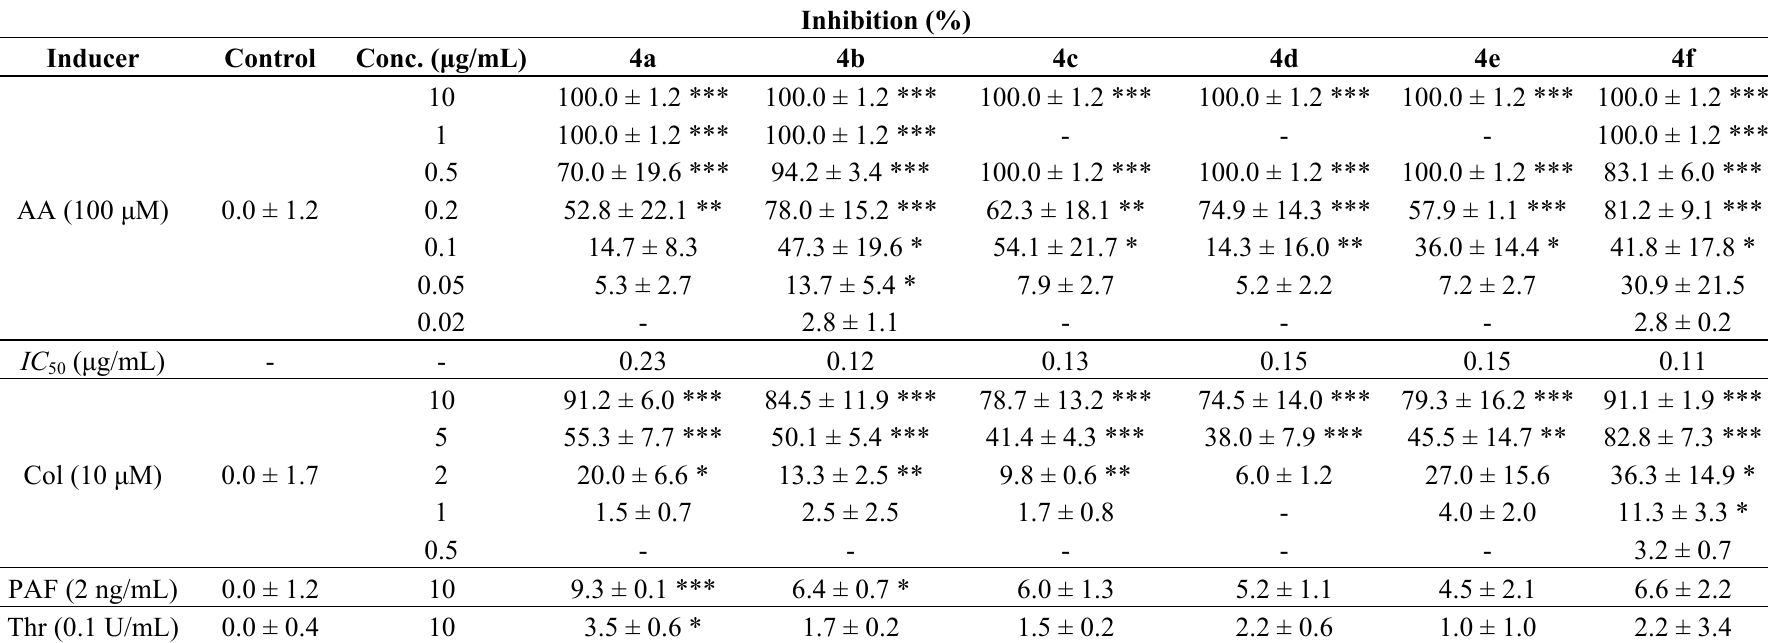
Table 8. Antiplatelet activity of [ n ]-shogaols 4a – f